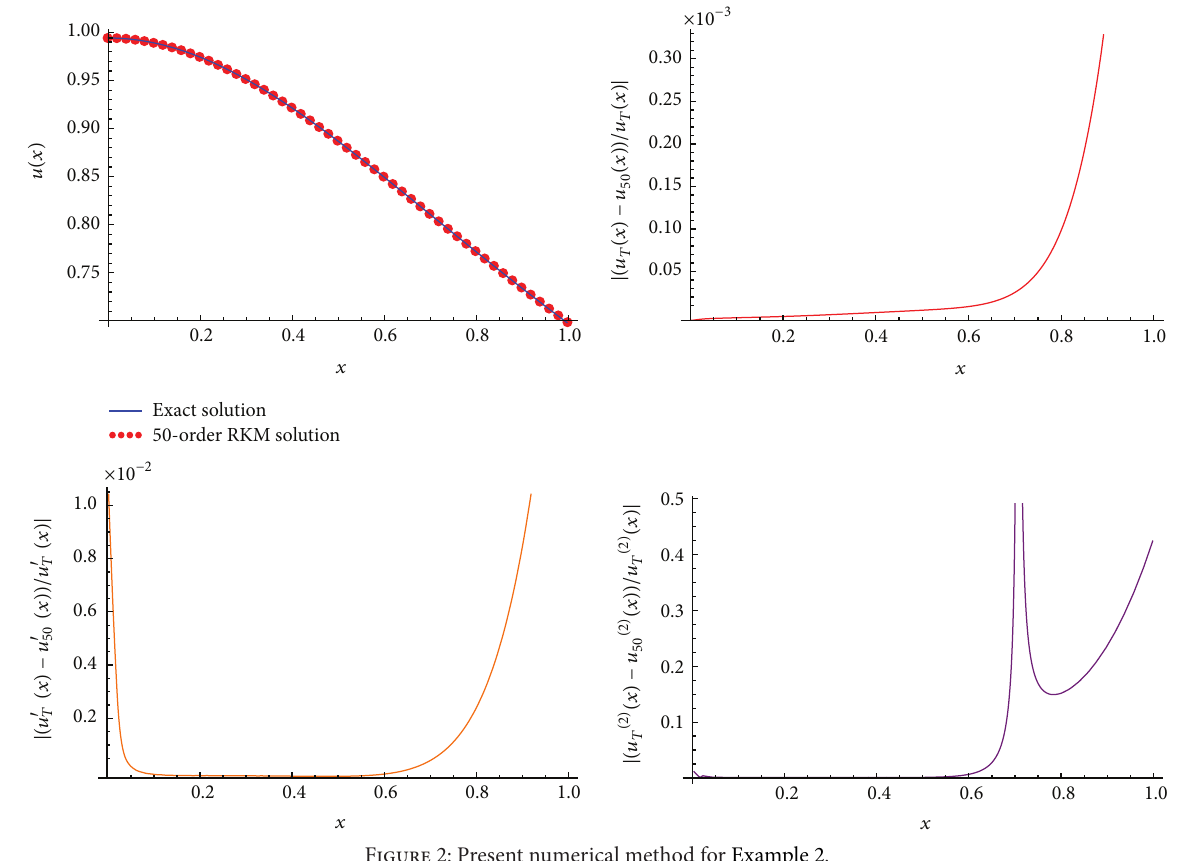
Figure 2: Present numerical method for Example 2. Table 1: Numerical solutions for Example